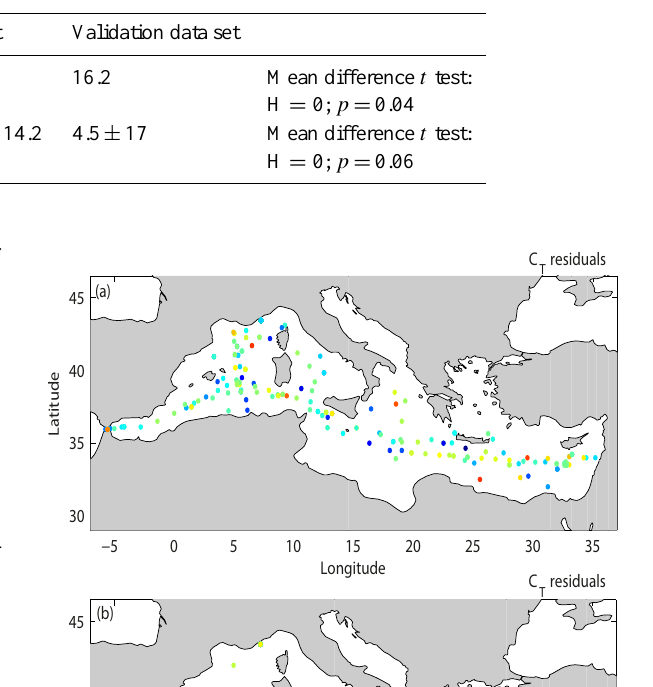
Table 4. Mean difference t test for the C T algorithm between the training and validation data sets